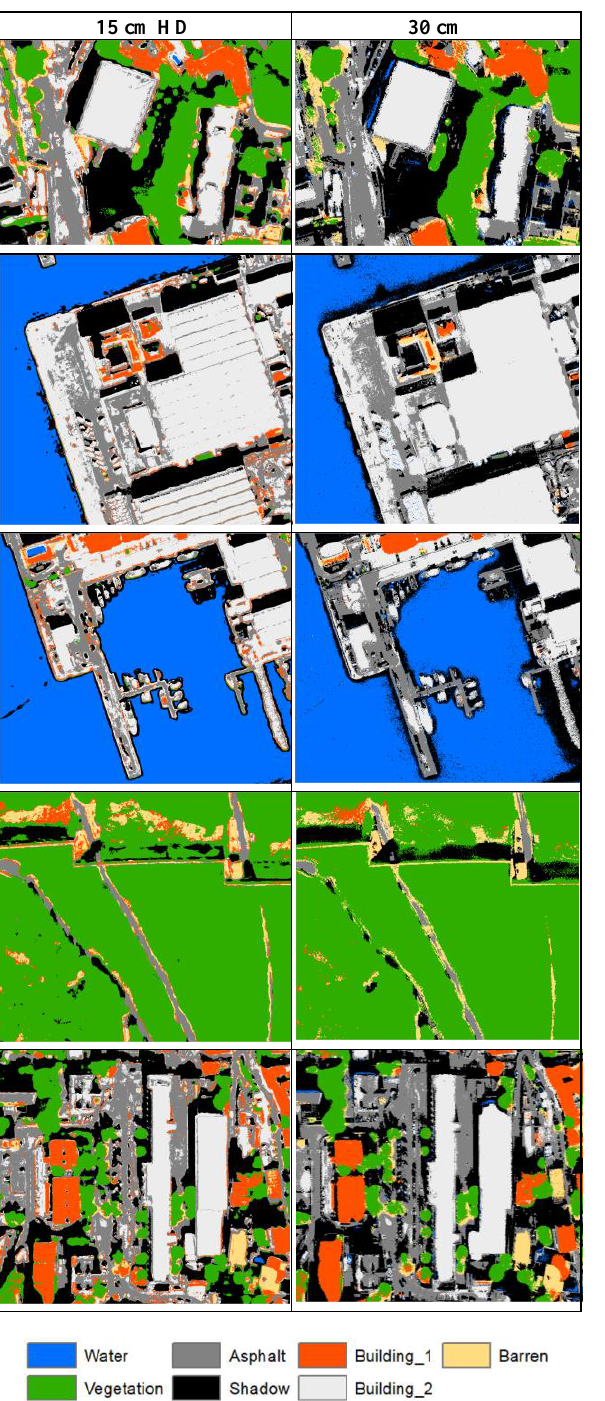
Figure 9. Image parts containing 15 cm HD and 30 cm RF model results in the Gibraltar region